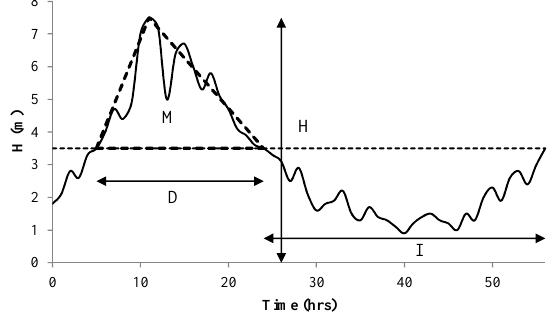
Fig. 2. Illustration of the storm definition showing the significant wave height H , storm duration D and calm period I